Question: Write the caption for this figure.
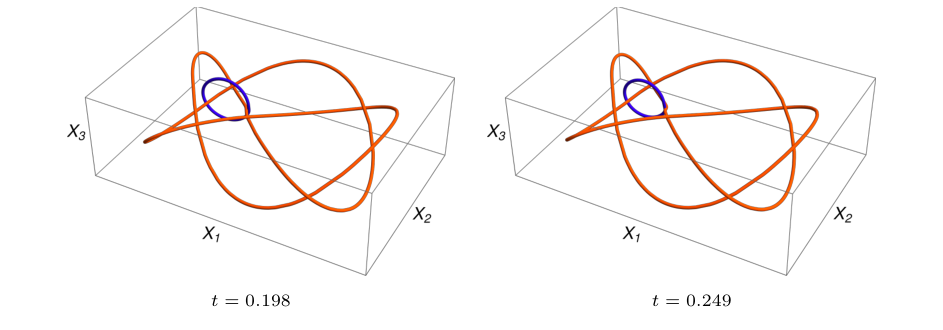
Answer: 2. The Listing’s 8-knot curve linked with a circle a) and an ellipse b)